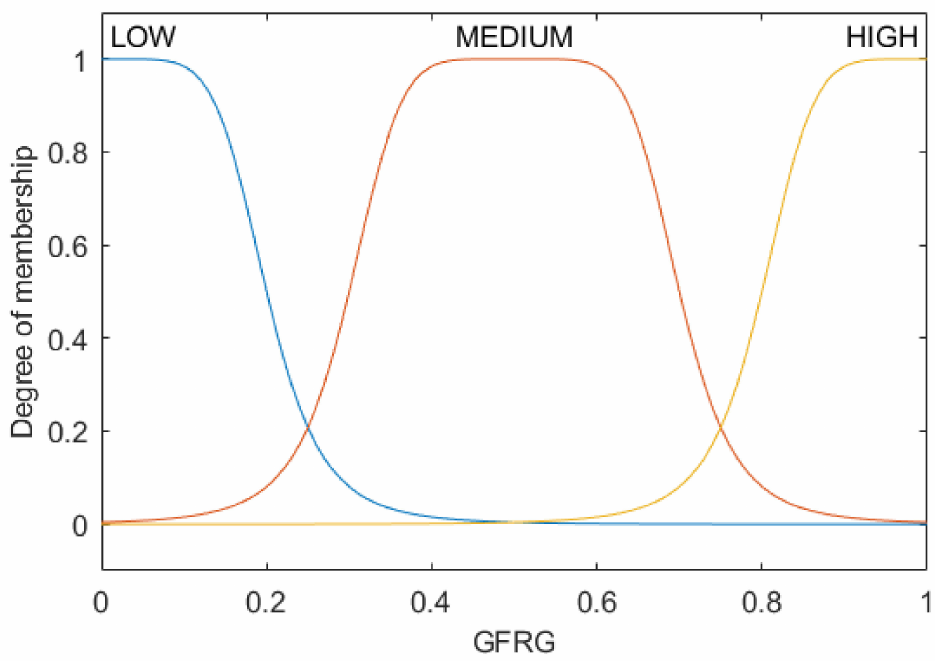
Figure 6. Example of Gbell membership function of